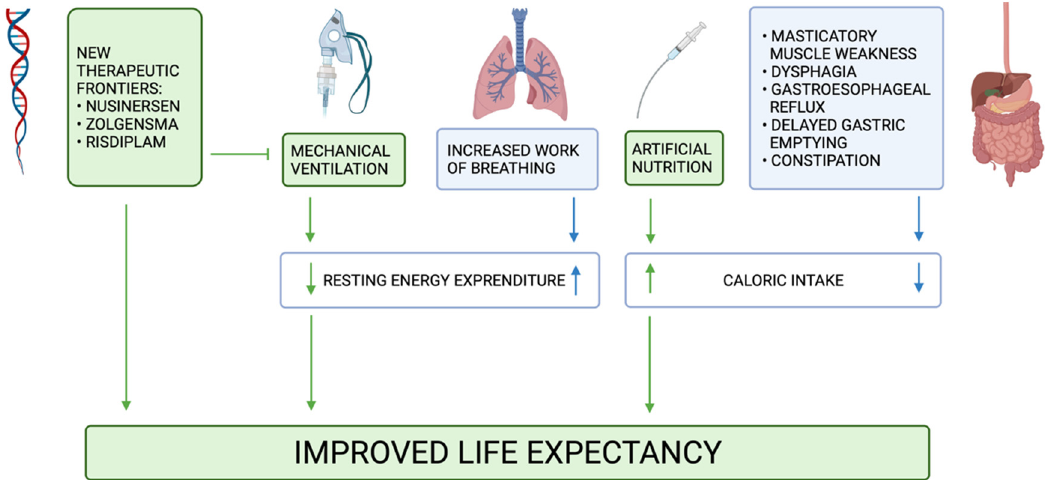
Figure 2. Mechanical ventilation and artificial nutrition, by decreasing the REE and increasing the energy intake respectively, have improved the life expectancy of patients with SMA. The common element of new therapeutic frontiers is to delay the use of mechanical ventilation.